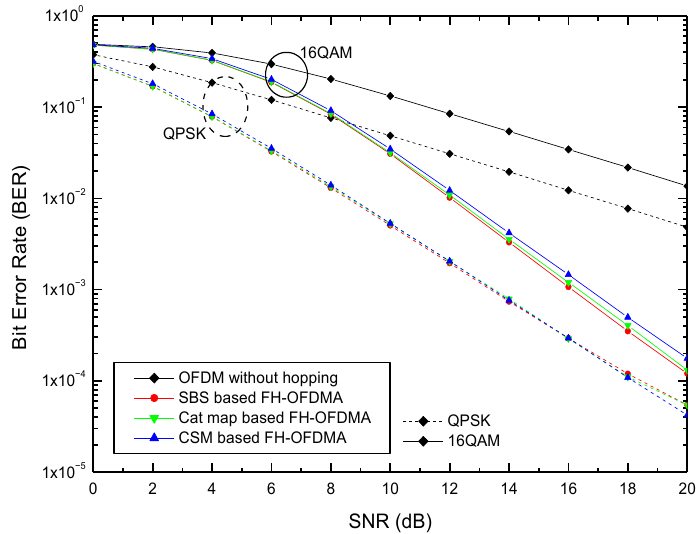
Figure 3. Bit error rate (BER) performances versus signal-to-noise ratio (SNR) compared to SBS, cat map, and CSM-based FH-OFDMA systems.